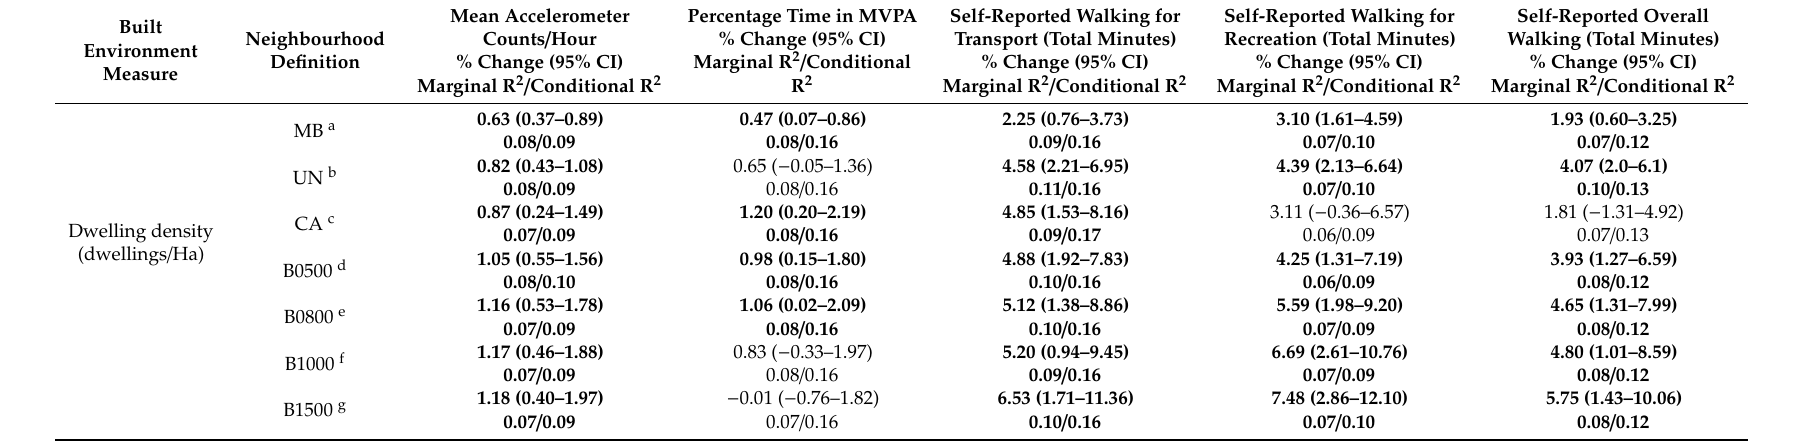
Table 5. Percentage change (95% CI) in fully adjusted models of physical activity, for a one unit change in the built environment measures for the seven neighbourhood boundaries. All models were fully adjusted for sex, age, ethnicity, income, marital status, education, employment, car access, neighbourhood socioeconomic deprivation and neighbourhood preference. Bold text indicates results where there was some evidence (confidence intervals did not cross zero) to support an association between the built environment and physical